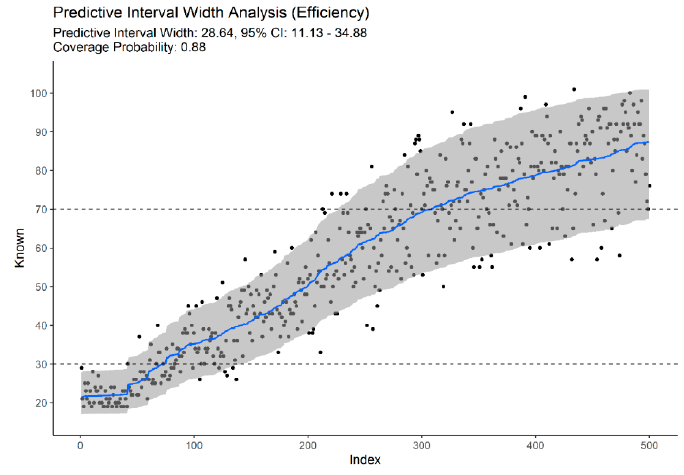
Figure 3. Predictive efficiency of standard age-related traits, α = 0.1.